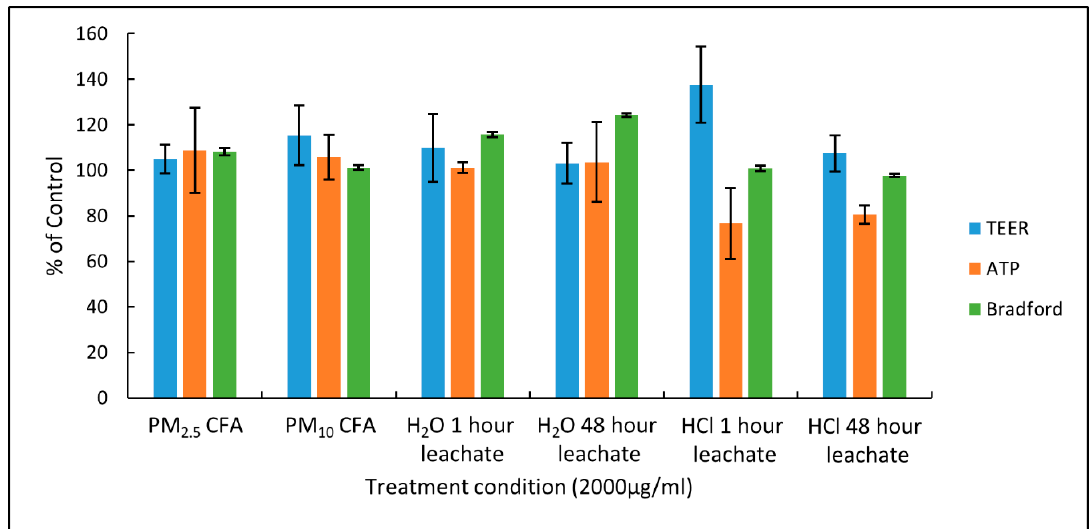
Figure 5. Trans-epithelial electrical resistance (TEER), ATP activity, and Bradford assay results following exposure of CFA and CFA leachates to EpiAirway bronchial epithelial cells. Values are given as a percentage of the control and are the mean of four repeats run on four individual cell inserts. Error bars display standard deviation (SD).